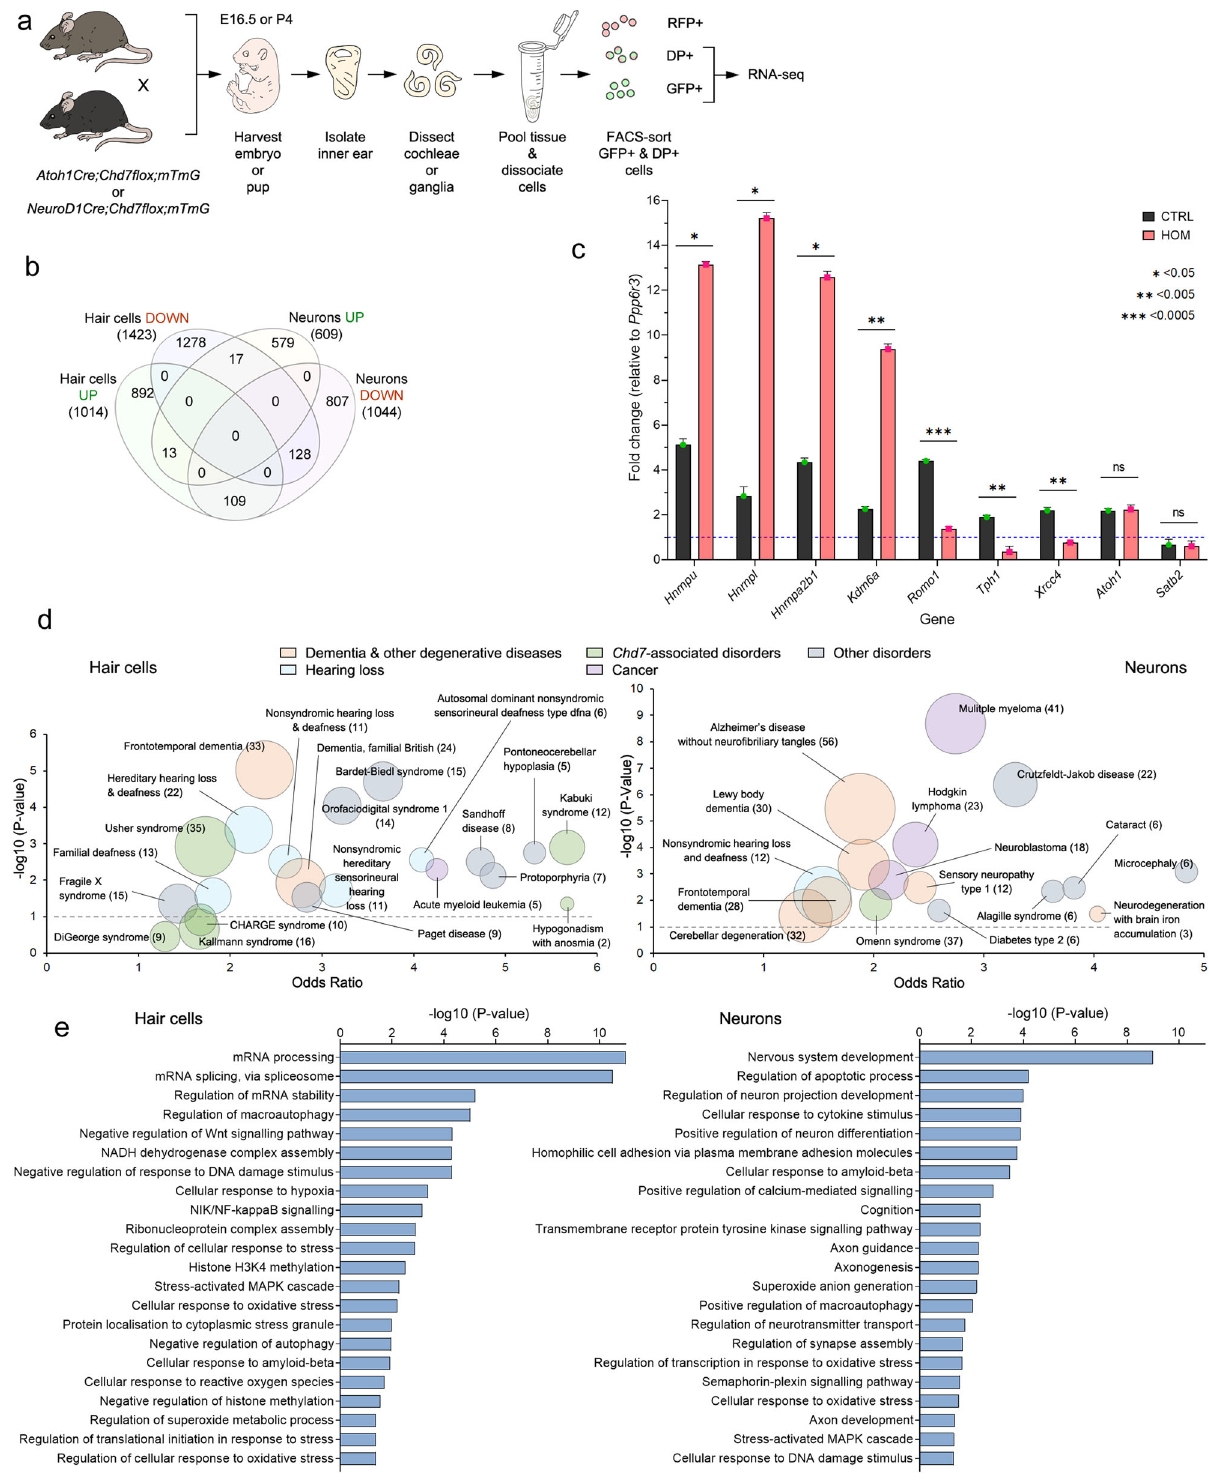
Fig. 5 Transcriptome analysis of control and Chd7 mutant hair cells and neurons reveals misregulation of cellular stress pathways. a Schematic showing the experimental approach used for RNA sequencing. DP = double positive. n = 6 cochleae or ganglia were pooled for RNA-seq in three independent experiments per genotype. b Comparison of the number of differentially expressed genes between hair cells and neurons in homozygotes. c qPCR expression analysis of genes in controls and homozygous FAC-sorted hair cells at E16.5. Error bars represent the standard error. P -values: * = <0.05, **<0.005, ***<0.0005. ns = not signi fi cant. d Plot of Odds ratio by − log10 of the P -value for human diseases identi fi ed by disease ontology. Odds ratio is used to determine the relative odds of the occurrence and magnitude of disease, given exposure to the risk factor (e.g., genes). Complete disease ontology is provided in Supplementary Data 5 and 6. e Gene ontology for differentially regulated genes. Complete gene ontology is provided in Supplementary Data 7 and